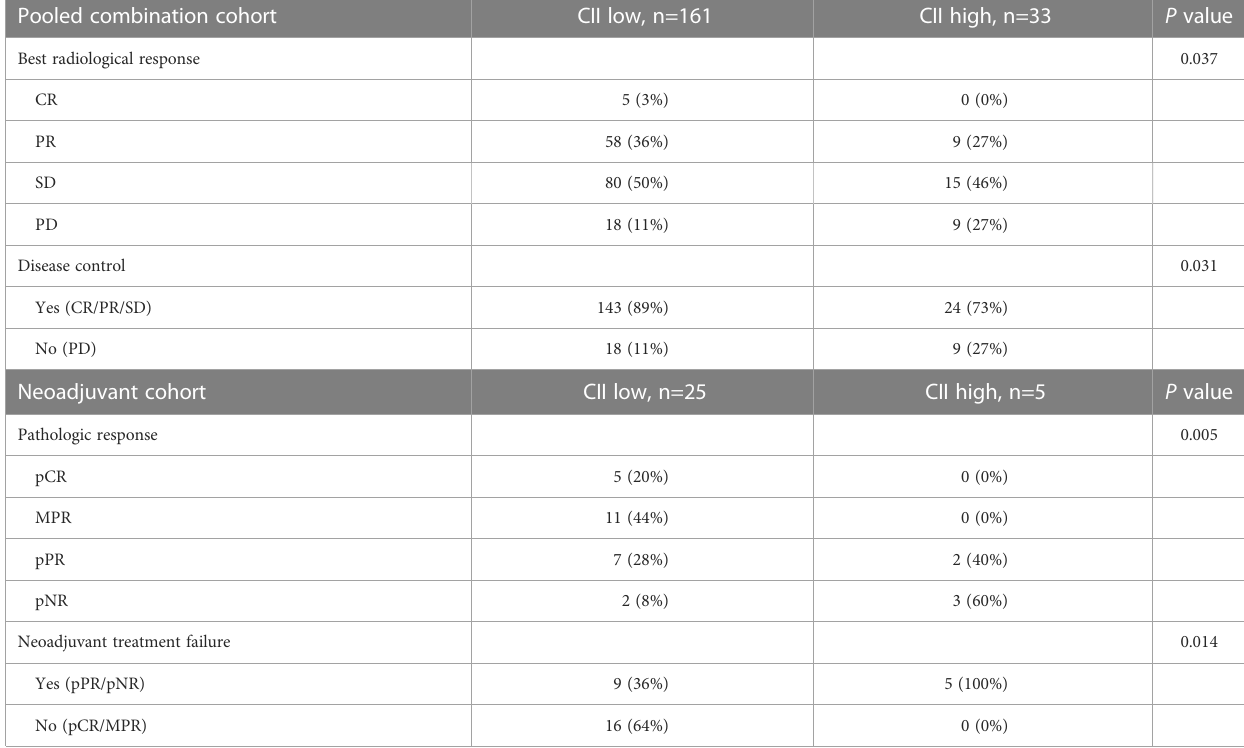
TABLE 3 Ef fi cacy according to CII in the pooled combination therapy cohort and neoadjuvant cohort. Pooled combination